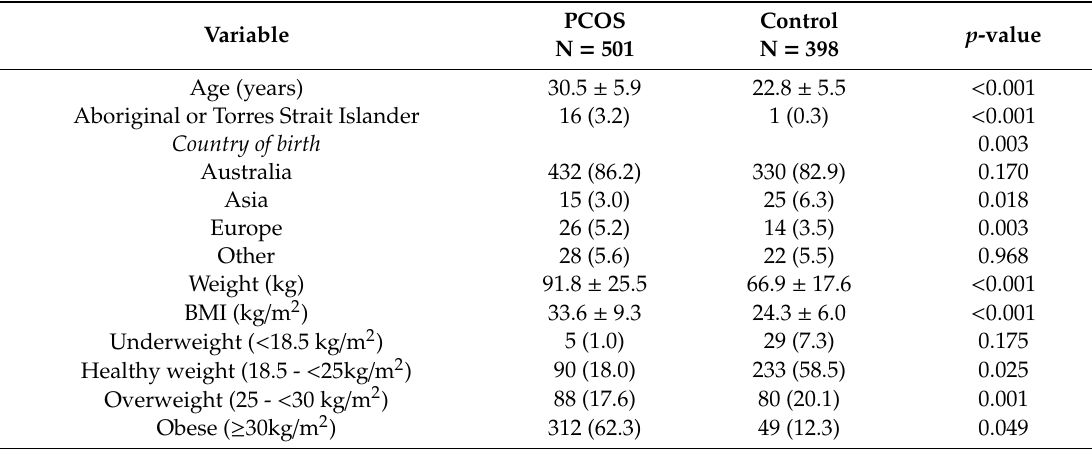
Table 1. Participant baseline